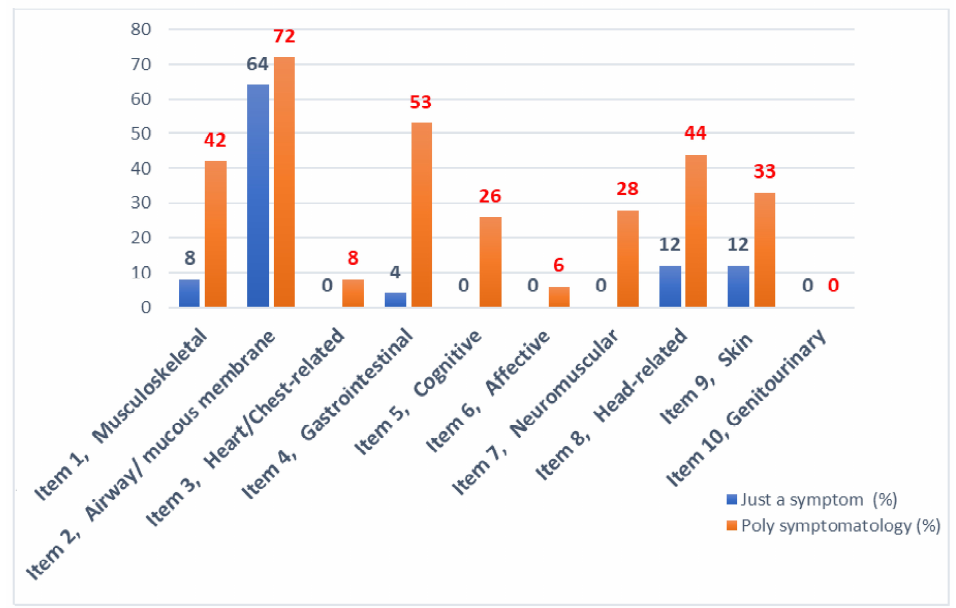
Figure 1. Percentage of patients with one symptom and with polysymptomatology at the onset of the disease and percentage of patients presenting the symptom